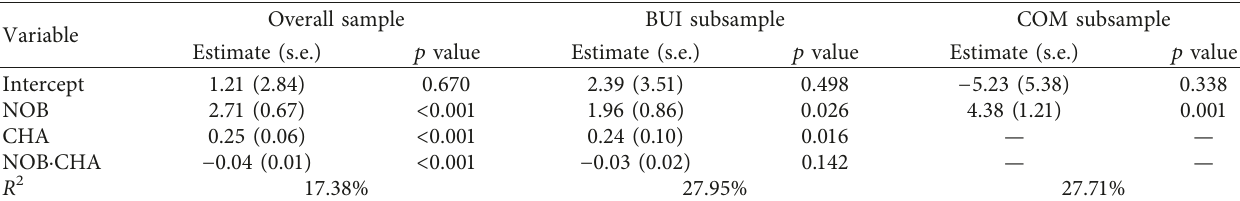
Table 5: Estimated linear models for the prediction of the achieved relative savings percentage based on the number of bidders, the number of changes, and its interaction, for the full construction e-RA auctions dataset and the BUI and COM types of contract subsets. The models have been chosen at a α � 0 . 05 global significance